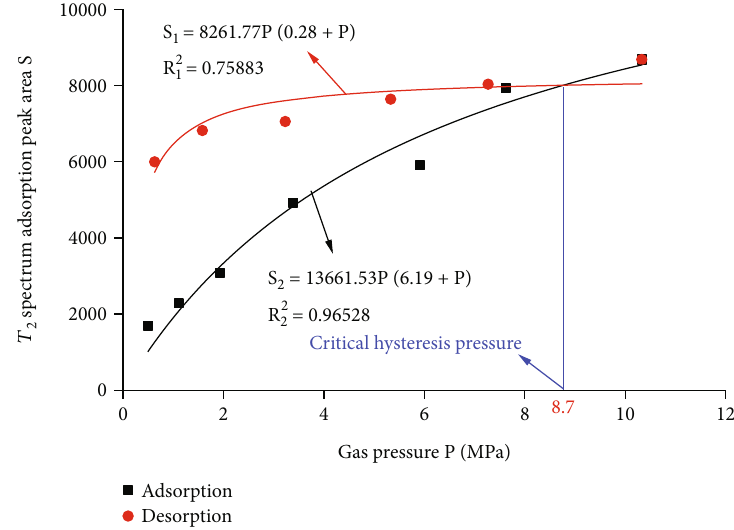
Figure 7: Adsorption peak area and gas pressure curve.